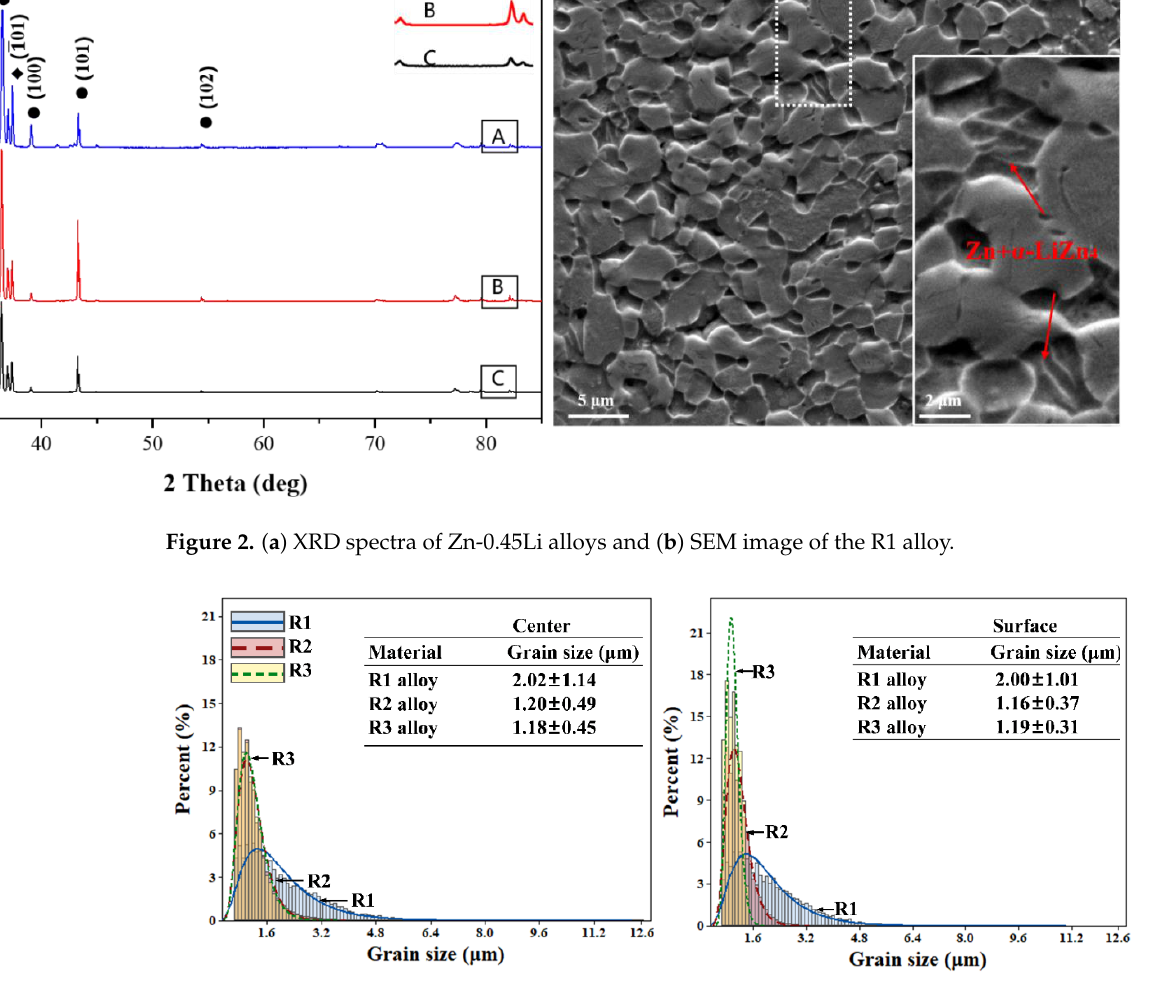
Figure 2. ( a ) XRD spectra of Zn-0.45Li alloys and ( b ) SEM image of the R1 alloy.